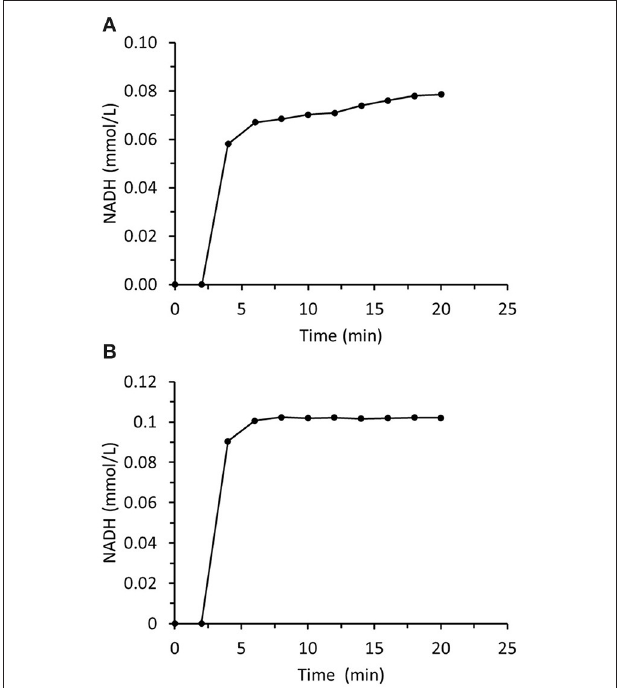
FIGURE 7 | Time dependence of NADH concentration in the output of the column packed with immobilized ScADH1. The column was fed with the substrate solution containing (A) − 0.17 mmol/L of NADH and 4 mmol/L of trans -2-hexenal; (B) − 1.7 mmol/L of NAD and 25 mmol/L of ethanol.